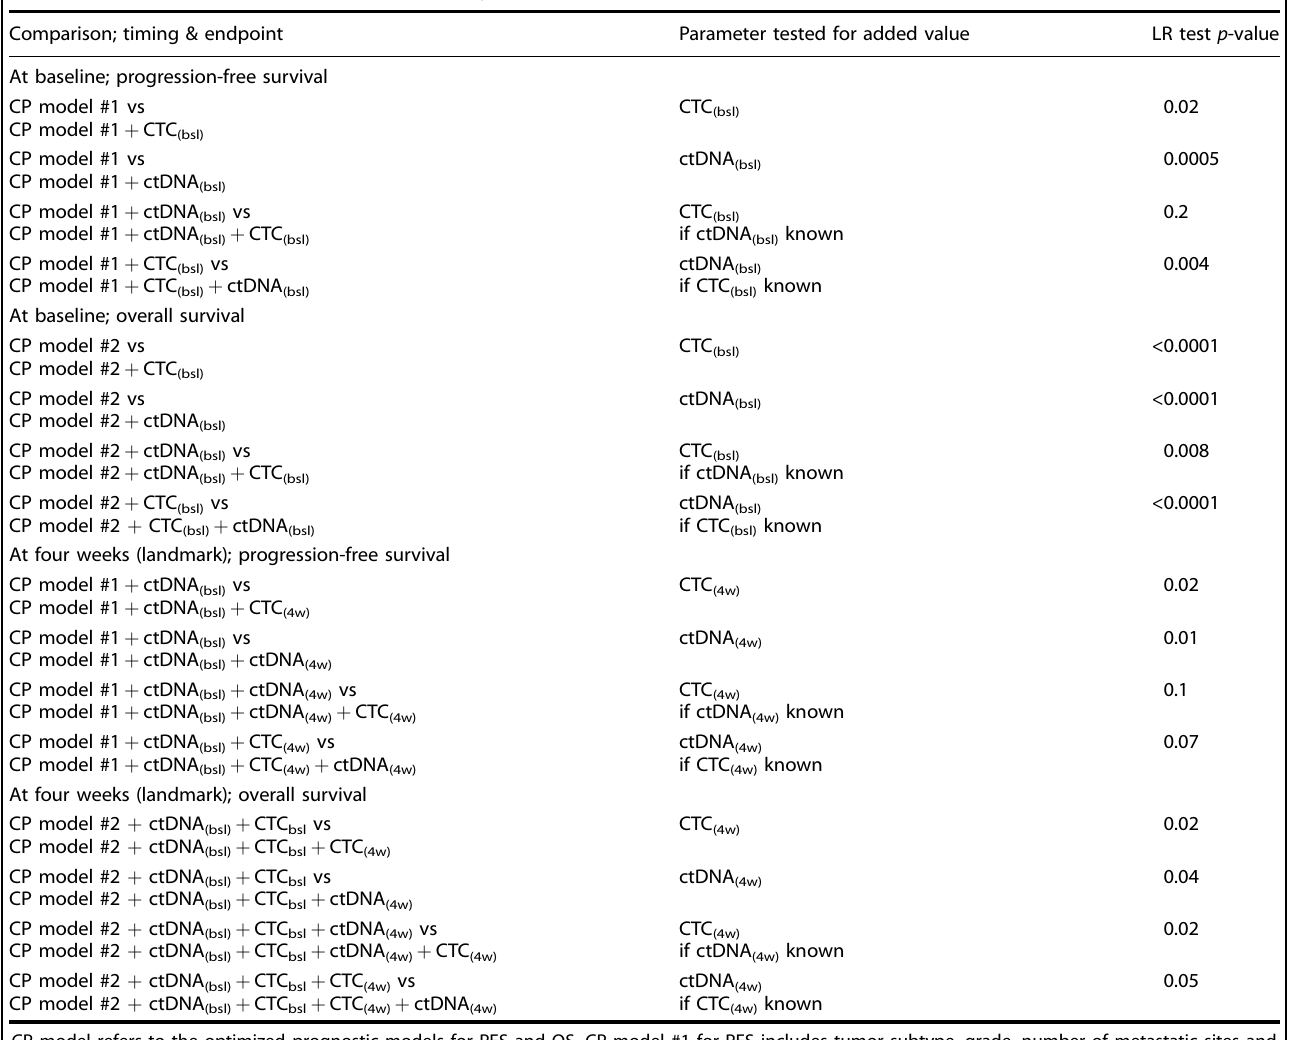
Table 2. Added value of blood tumor markers to prognostic models.